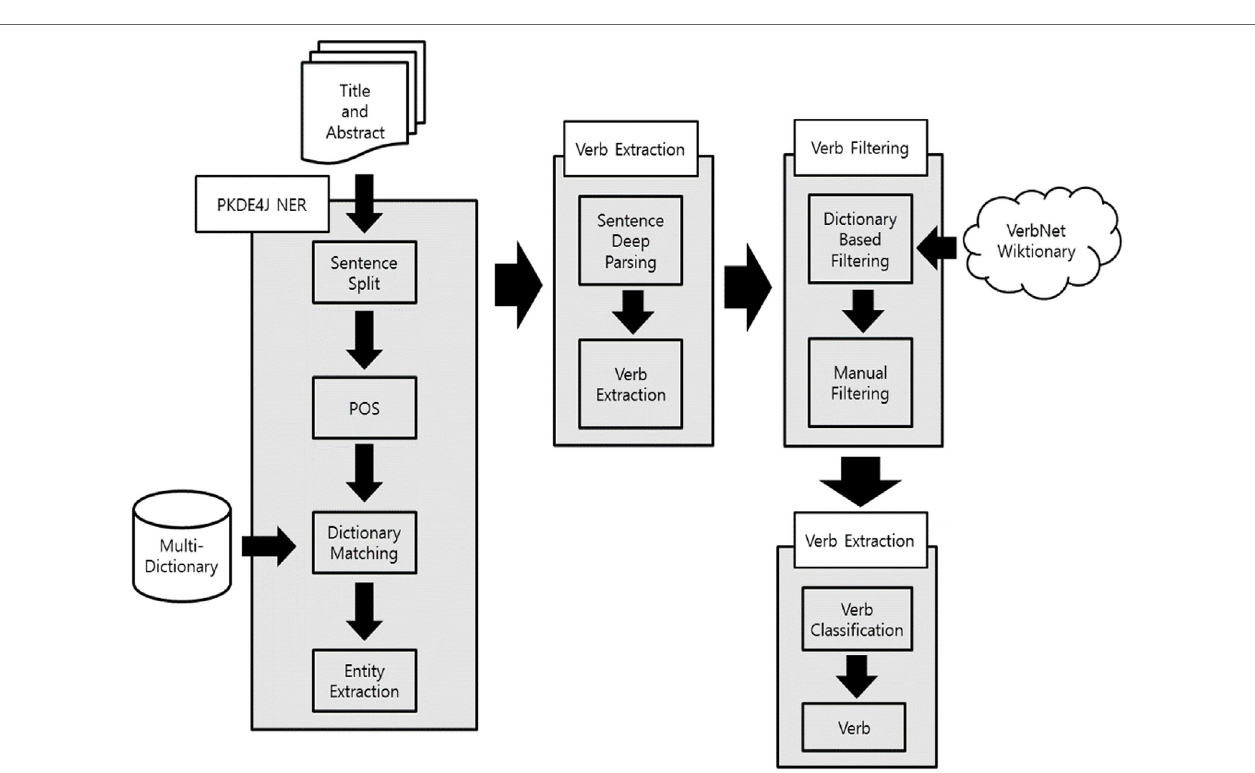
FigUre 3 | Outline of method for biomedical verb